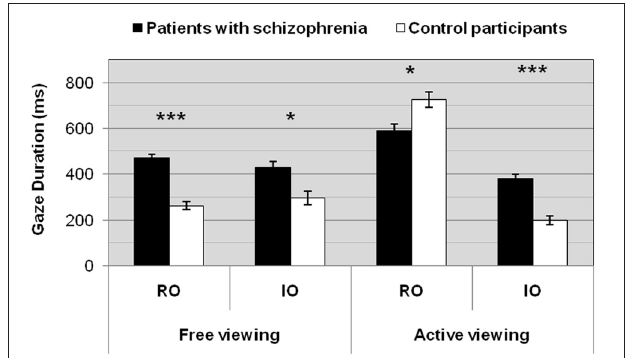
FIGURE 2 | Gaze durations for patients and controls as a function of the task. ∗ p < 0 . 01; ∗∗∗ p < 0 . 0001. RO, relevant objects; IO, irrelevant